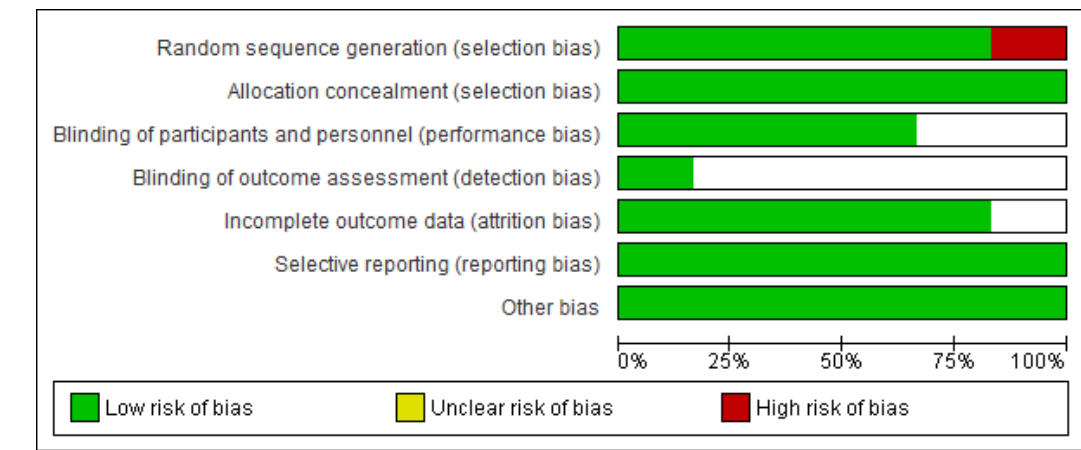
Figure 2. Risk of bias graph: review authors′ judgements about each risk of bias item presented as percentages across all included studies.